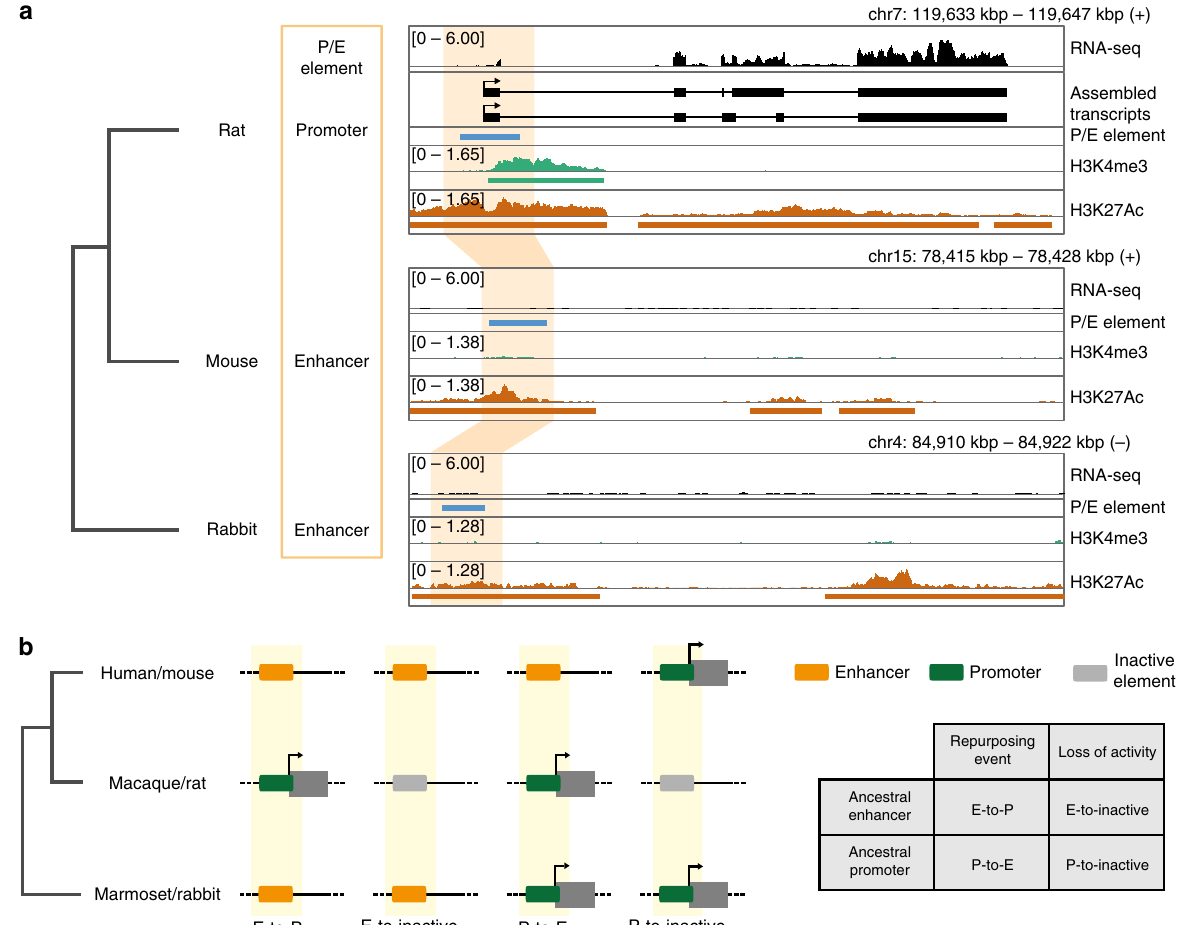
Fig. 2 Repurposing of an ancestral glires enhancer. a The coordinates of a rodent P/E element, with enhancers activity in mouse and promoter activity in rat, are projected onto the rabbit genome (orange shaded area). The syntenic region in rabbit overlaps an H3K27ac peak but no H3K4me3 peak. The presence of a transcript in rat and absence of transcripts in mouse and rabbit are evident based on the RNA-seq tracks. For each species (from top to bottom) are shown: the RNA-seq coverage from liver; the assembled transcripts (only in rat); the P/E element locus; the liver H3K4me3 and H3K27Ac coverage and peaks from Villar et al. (2015). b Scheme depicting the different types of turnover events (Regulatory repurposing vs evolutionary loss) for